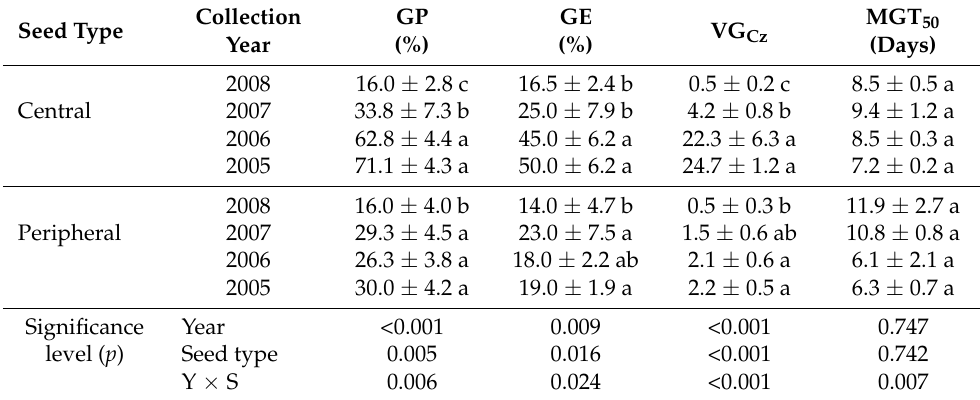
Table 6. Mean values ( ± SE) and significance level ( p ) of the germination parameters assessed in the greenhouse and under natural light, after different storage periods from collection, using seeds collected in June of each year. The test was carried out in July 2008.